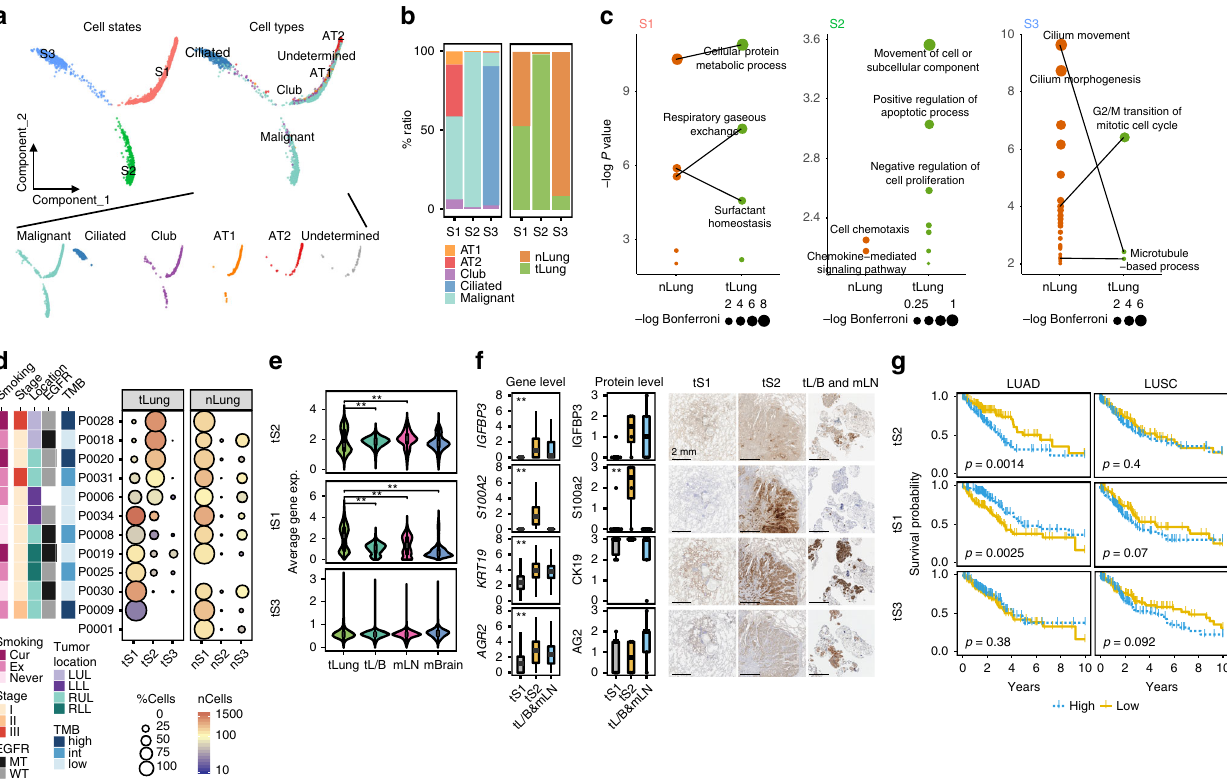
Fig. 2 Identi fi cation of novel cancer cell signature tS2 in LUAD and the connection to poor survival. a Unsupervised transcriptional trajectory of malignant and normal epithelial cells from Monocle (version 2), colored by cell states and subsets. b Relative proportion of cell subsets and tissue origins for each cell state as shown in ( a ). c Functional categories (Gene Ontology terms) of signature genes speci fi c to each cell state as shown in ( a ). d Different enrichment of cell states within tLung and nLung, and associated clinical parameters. The clinical and pathological parameters originated from tLung. Cur: current smoker; Ex: ex-smoker; Never: never smoker; LUL: left upper lobe; LLL: left lower lobe; RUL: right upper lobe; RLL: right lower lobe. e Changes in average tumor cell state-speci fi c signature gene expression with lung cancer progression (tLung and tL/B) and metastasis (mLN and mBrain). **, two-sided Wilcoxon test p -value < 0.01. f Box plots depicting single-cell gene expression and the quanti fi ed protein levels of selected markers speci fi c to the tS2 epithelial subset. tS1-enriched tLung ( n = 7; T06, T08, T09, T19, T25, T30, T34), tS2-enriched tLung ( n = 4; T18, T20, T28, T31), and tL/B & mLN ( n = 5; EBUS_06, EBUS_10, EBUS_13, EBUS_19, EBUS_28). **, one-way ANOVA test p -value < 0.01. Each box represents the interquartile range (IQR, the range between the 25th and 75th percentile) with the mid-point of the data, whiskers indicate the upper and lower value within 1.5 times the IQR. IHC staining of IGFBP3, S100a2, CK19, and AG2 on formalin- fi xed and paraf fi n-embedded slides for the tS1 (T19), tS2 (T28), and tL/B & mLN (EBUS_10) samples. Scale bar, 2 mm. g , Kaplan – Meier overall survival curves of TCGA LUAD ( n = 494 samples), and LUSC ( n = 490 samples) patients. + : censored observations. P - value ( p ) was calculated using the two-sided log-rank